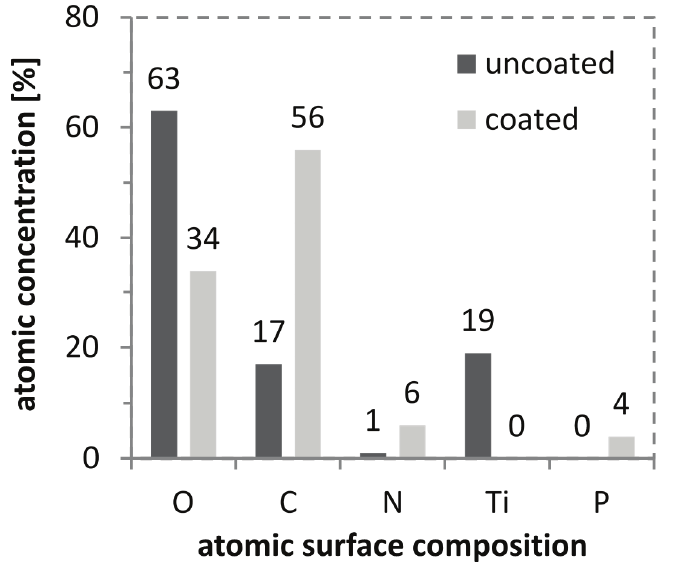
Figure 5. XPS measurement of a spray-coated chitosan-tripolyphosphate nanoparticle solution film (3:1, 1 mg/mL, 0.075% AcOH, DA 42%) on a titanium substrate and a blank substrate showing the atomic concentrations on the substrates